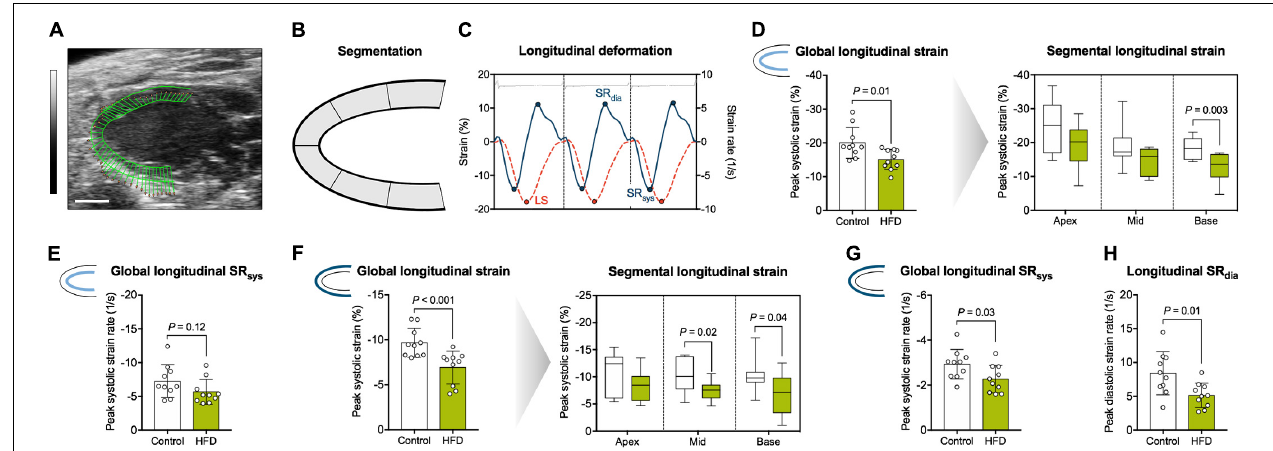
FIGURE 3 | Analysis of myocardial longitudinal deformation. (A) Representative B-Mode image in the parasternal long axis view used for speckle-tracking analysis (scale bar = 2 mm; vector arrows along the endocardial border). (B) The myocardium was divided into six segments, and longitudinal strain was assessed as their average (global longitudinal strain) or separately for basal, mid-cavity and apical segments (segmental longitudinal strain). (C) Representative longitudinal strain (orange dotted line) and -strain rate (blue solid line) curves along the endocardial border during three consecutive cardiac cycles. LS indicates longitudinal peak systolic strain. Peak strain rate was assessed during diastole (SR dia ) and systole (SR sys ), respectively. The interval between two R waves was defined as one cardiac cycle (corresponding ECG tracing is displayed on top). (D) Analysis of endocardial longitudinal strain. (E) Analysis of endocardial longitudinal SR sys . (F) Analysis of epicardial longitudinal strain. (G) Analysis of epicardial longitudinal SR sys . (H) Analysis of longitudinal SR dia . Mean ± SD or median and quartiles with 95% confidence interval; n = 10–11 per group; unpaired Student’s t -test or Mann-Whitney U test.